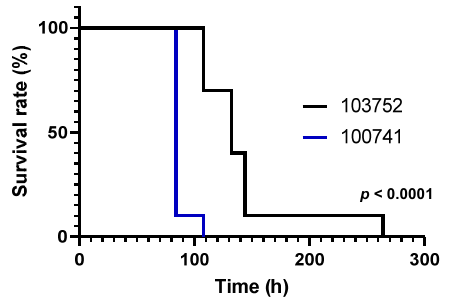
Figure 1. The effect of C. militaris conidia injection into silkworm larvae. Black and blue lines indicate C. militaris NBRC103752 and NBRC100741, respectively ( n = 10, triplicate). Results are significantly different using the log-rank test ( p < 0.0001, χ 2 = 53.64). PBS was injected into silkworm larvae as a control (data not shown).